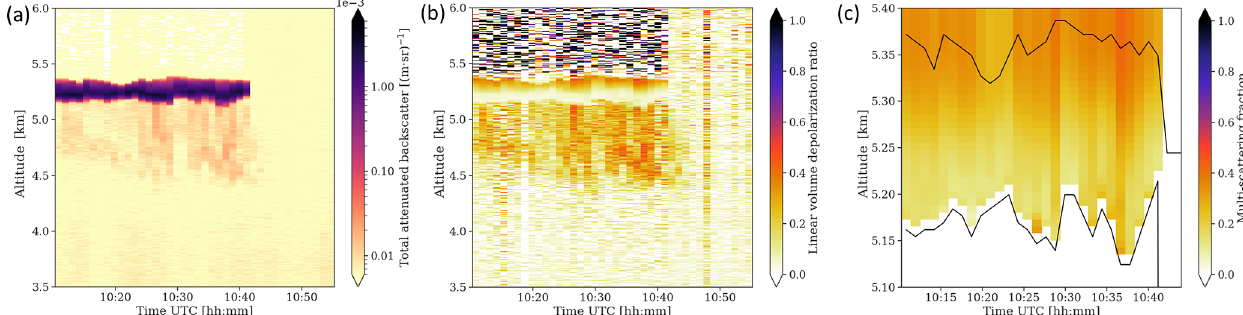
Figure 4. (a) Total attenuated backscatter (TAB), (b) the linear volume depolarization ratio at 532nm, and (c) the accumulated multiple- scattering fraction inside the liquid cloud body. The black lines indicate the cloud base and top of the liquid cloud body, as identified from the combined parallel and cross-parallel signal. The multiple-scattering fraction is accumulated from cloud